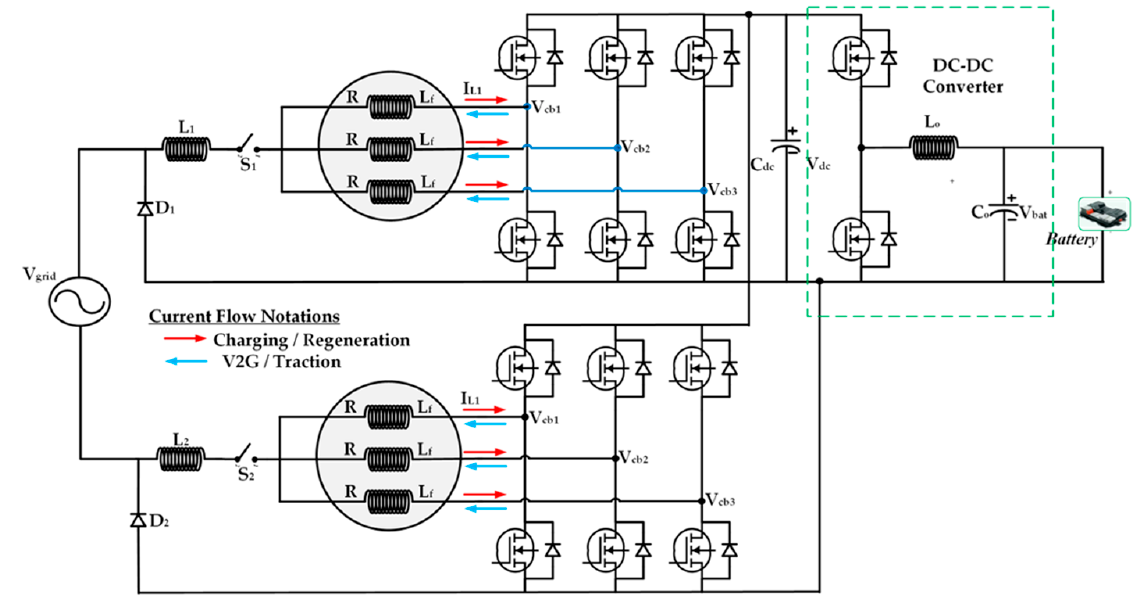
Energies 2022 , 15 , x FOR PEER REVIEW Figure 5. Single motor drive integrated on-board charger proposed by Gupta et al. [61] in 2020 (iOBC1).